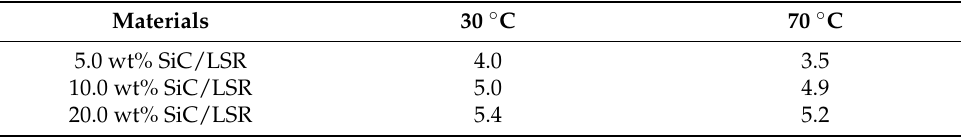
Table 3. Hopping distance of percolation conductance in the SiC/LSR composites.